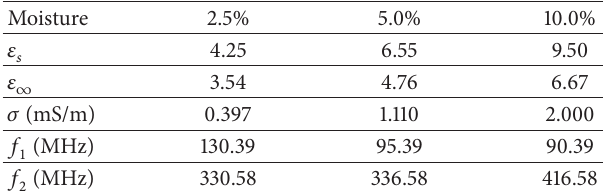
Table 1: Lorentz model parameters of the Puerto Rico type clay loams (analysis from 30MHz to 3840